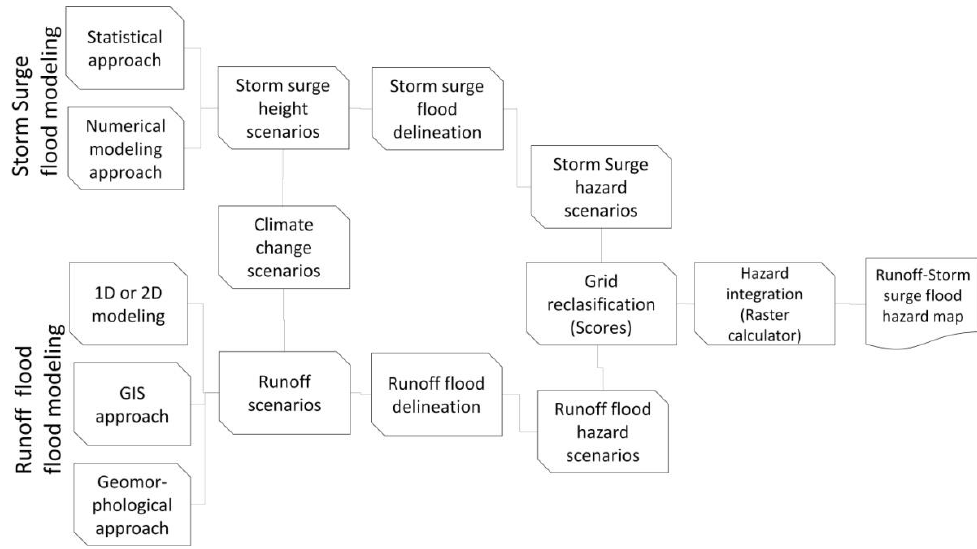
Figure 2. Flowchart for the elaboration of the runoff-storm surge flood hazard Map.